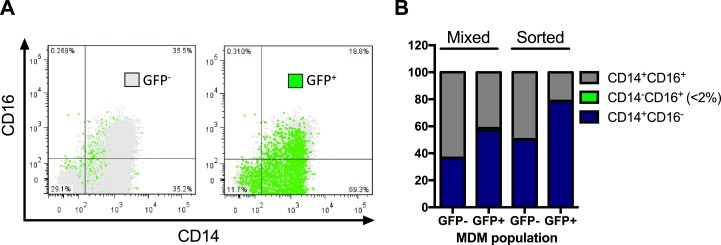
GFP expression from HIVNL4.3 infected MDM populations does not strongly correlate with CD14 and CD16 expression.MDMs (dpi = 3) were initially distinguished by their characteristic FSC and SSC and then assessed for their expression levels of CD14 and CD16 markers. (A) MDMs were sorted according to GFP expression using FACS and then double stained for CD14 and CD16 expression before analysis by flow cytometry. (B) The relative CD14 and CD16 marker expression levels in mixed and GFP-sorted MDM populations were quantified using flow cytometry.